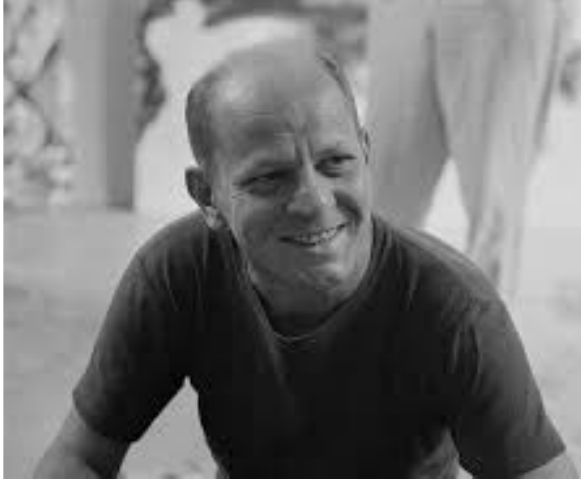
Figure 8 | Jackson Pollock (1912-1956.